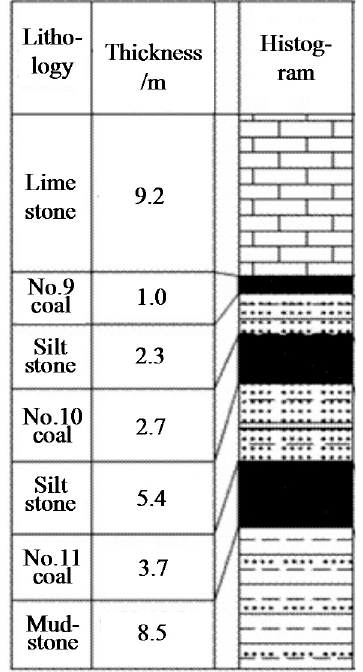
Figure 2. Geologic column of Panel 11-101.